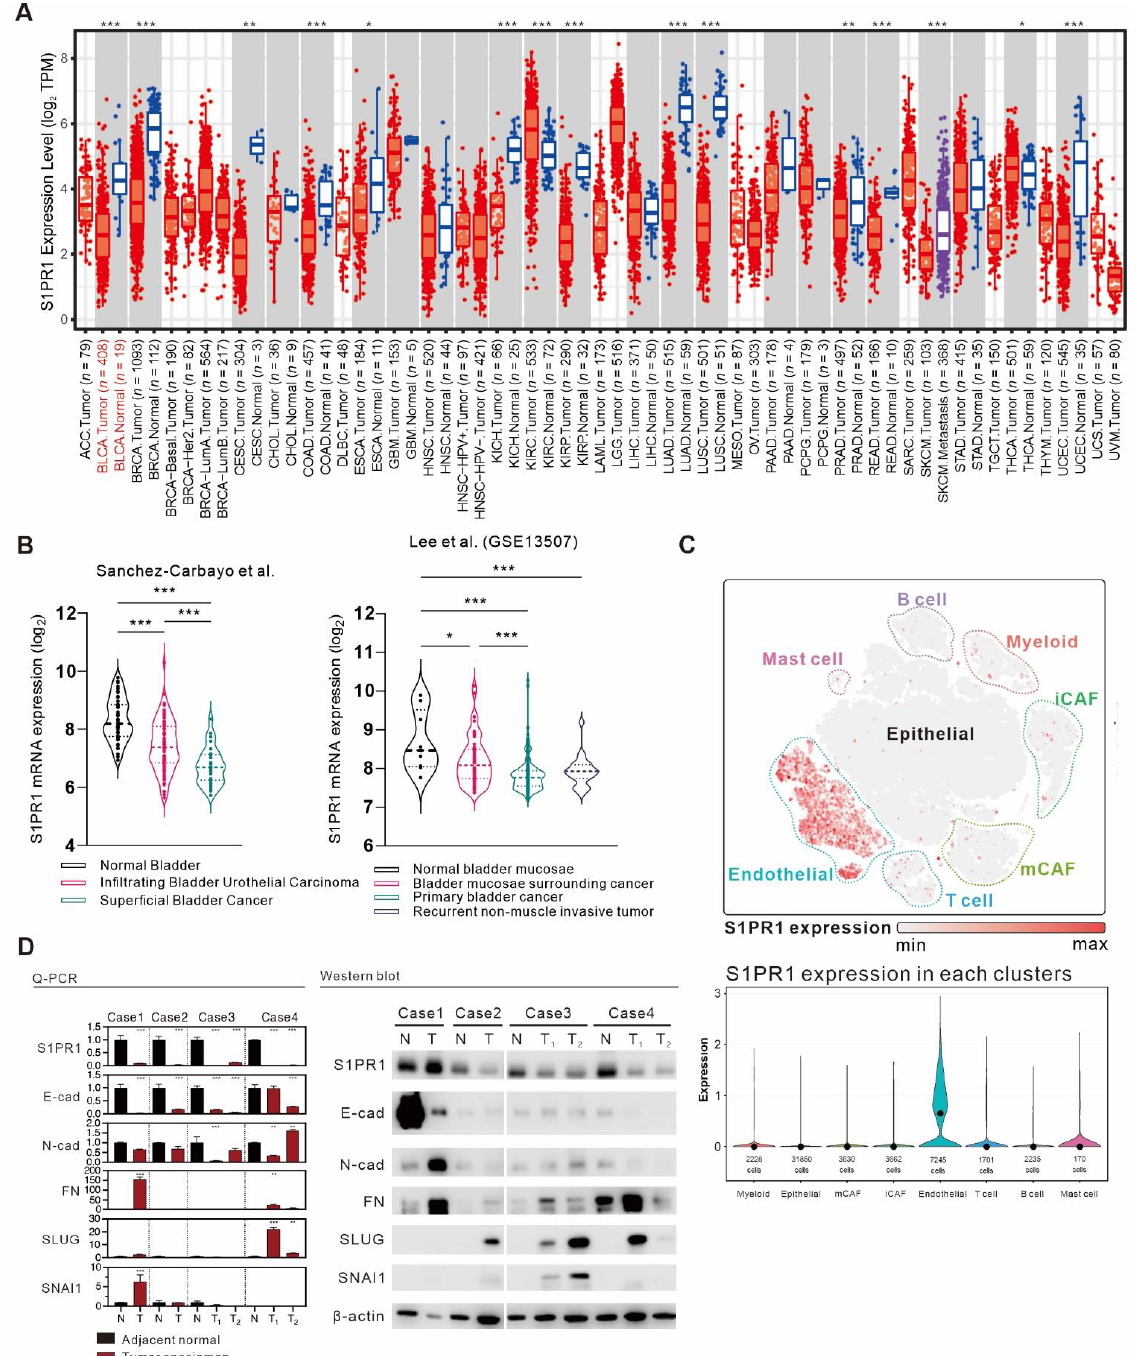
Figure 4. A comprehensive analysis of the differences in S1PR1 expression in bladder cancer tumors versus normal tissues. ( A ) Differences in S1PR1 expression in tumors and normal tissues among the 34 cancer types of TCGA adopted from TIMER 2.0 searching “S1PR1”. ( B ) Differences in S1PR1 expression in normal versus clinically defined histopathological